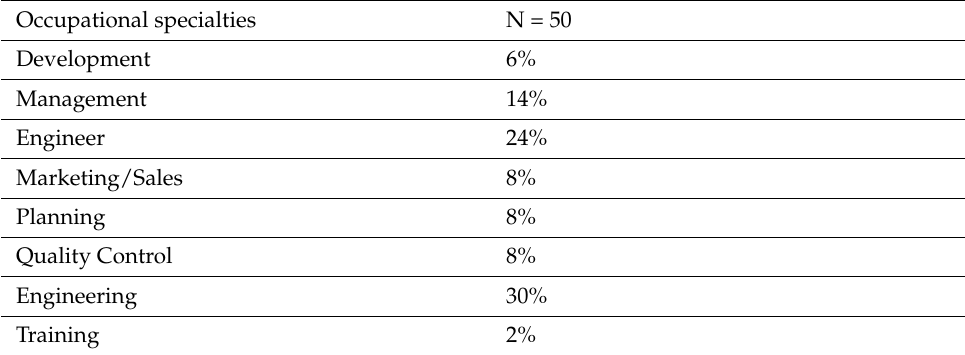
Table 9. Evaluation of demographic data.—Occupational